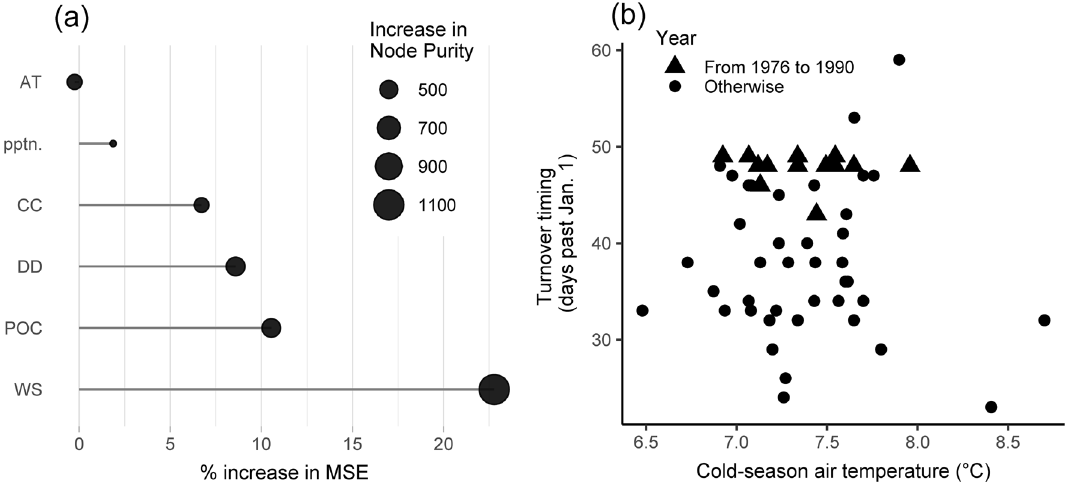
Figure 4. Analysis results of the relationship between potential variables and turnover timing: ( a ) the importance of variables importance using a random forest analysis, and ( b ) the relationship between the cold season air temperature and the timing of turnover. Variable importance is calculated using the percentage increase in mean square error (MSE) and the increase in node purity. Higher values illustrate the greater importance of the variable. Variables include air temperature (AT), precipitation (pptn.), cloud cover (CC), the difference in density (DD), POC, and wind speed